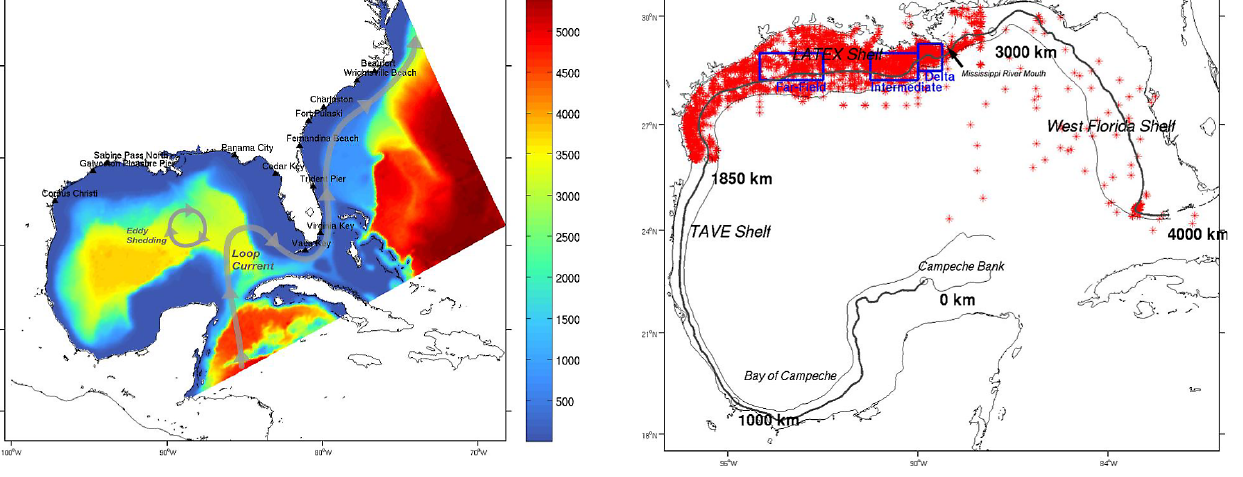
Fig. 2. Locations (star) of in situ ship survey data. Also shown are the 50 and 200m isobaths in the Gulf of Mexico, and the lo- cation of three subregions: Delta, Intermediate, and Far-field. Us- ing the 50m isobath as the boundary between the inner shelf and deep ocean ( ∼ 4000km long), we divide the shelf areas in the gulf into 4 major sections (see Fig. 2): (1) the Bay of Campeche shelf (bounded by the 50m isobath between 0 and 1000 km starting from the Campeche Bank, (2) the Tamaulipas–Veracruz shelf (bounded by the 50m isobath between 1000 and 1850km), (3) the LATEX shelf (bounded by the 50m isobath between 1850 and 3000km), and (4) the West Florida Shelf (bounded by the 50m isobath be- tween 3000 and